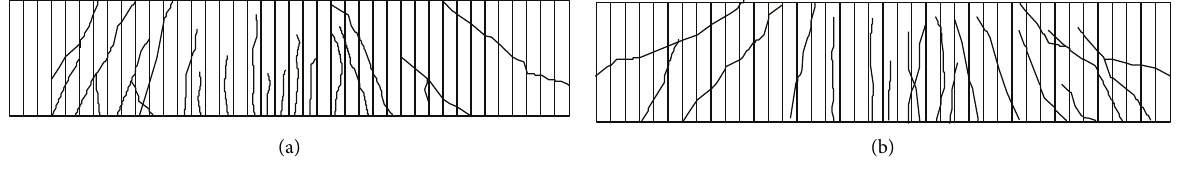
Figure 5: Fracture correlation. (a) Crack distribution in the web of No. 0 test beam. (b) Crack distribution in the web of No. 1 test